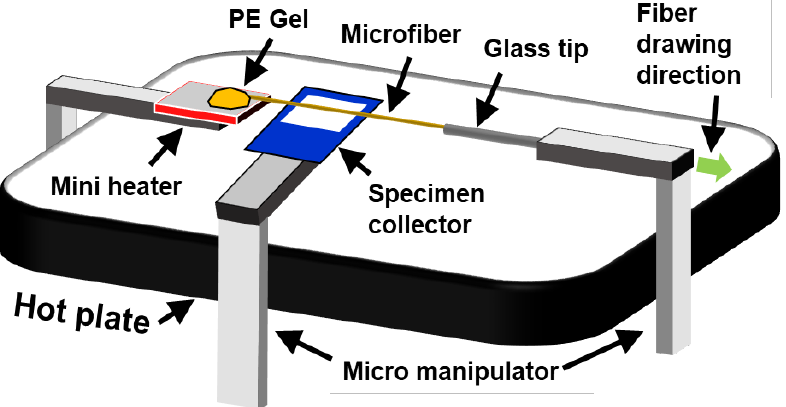
Figure 1. Schematic of tip drawing setup.